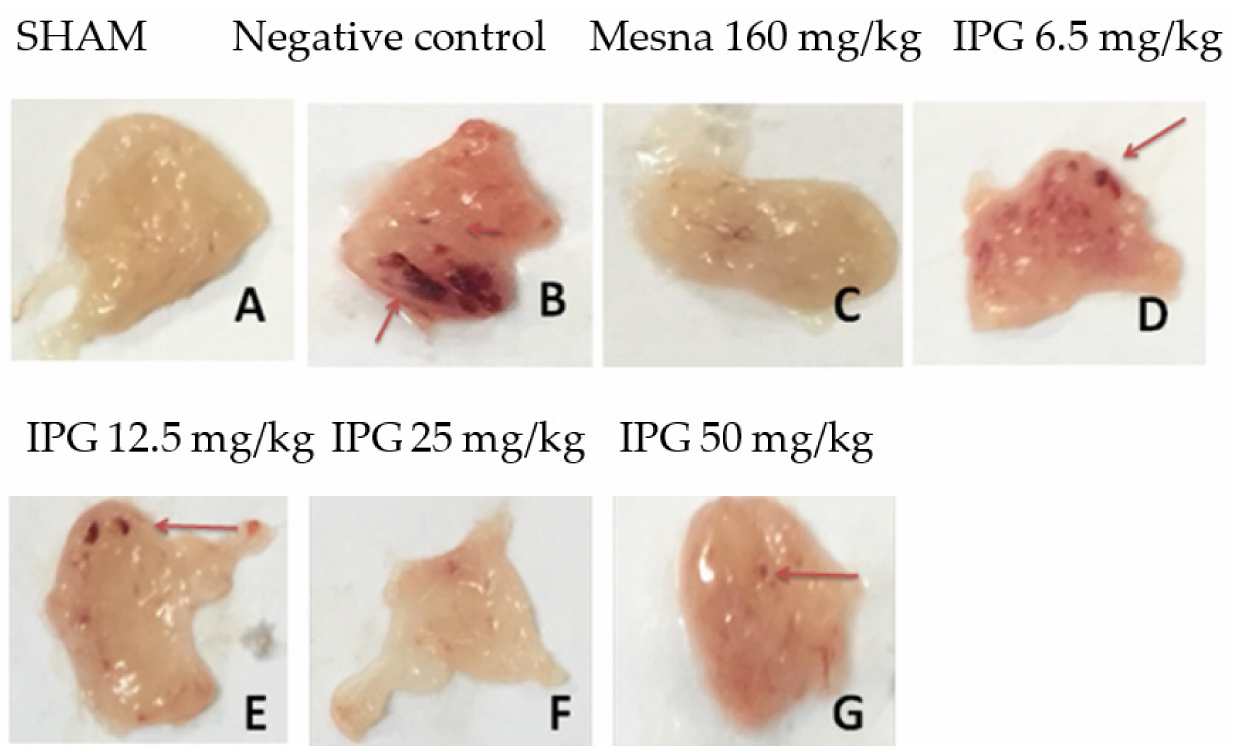
Figure 3. Effects of IPG on macroscopic parameters of hemorrhagic cystitis induced by ifosfamide. ( A ) Group “Sham” received only saline as a placebo, without induction of hemorrhagic cystitis. ( B ) The negative control group were treated with the vehicle (Tween/saline) before induction of hemorrhagic cystitis. ( C ) The positive control group were treated intraperitoneally with Mesna (2-mercaptoethanesulfonate sodium) before induction of hemorrhagic cystitis. Meanwhile, ( D – G ) the other groups were orally pretreated with IPG (6.25, 12.5, 25, and 50 mg/kg, respectively) before induction of hemorrhagic cystitis. The choice of the above images was based on the selection of a bladder considered the median among each